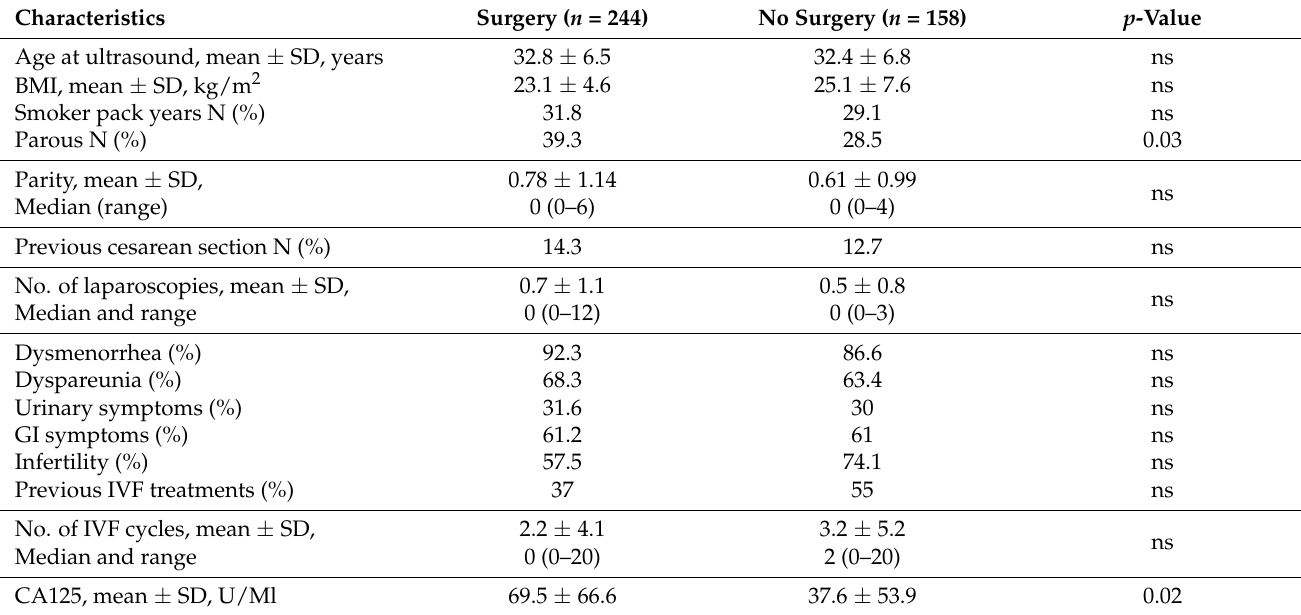
Table 1. Demographic data, history, and symptoms of women who underwent TVUS and subsequent laparoscopic surgery for endometriosis compared with those who did not undergo